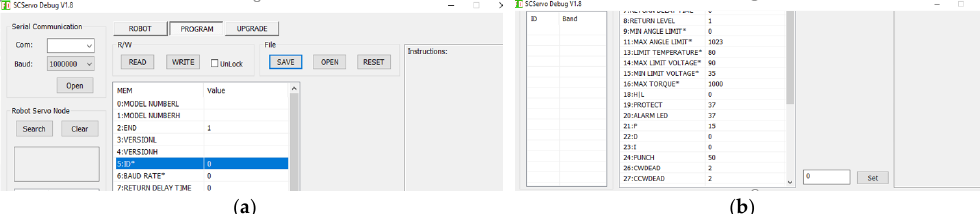
Figure 9. Feetech FD-v1.8 software application: ( a ) defining the ID of servo motor; ( b ) menu for kinematic and dynamic parameters definition.